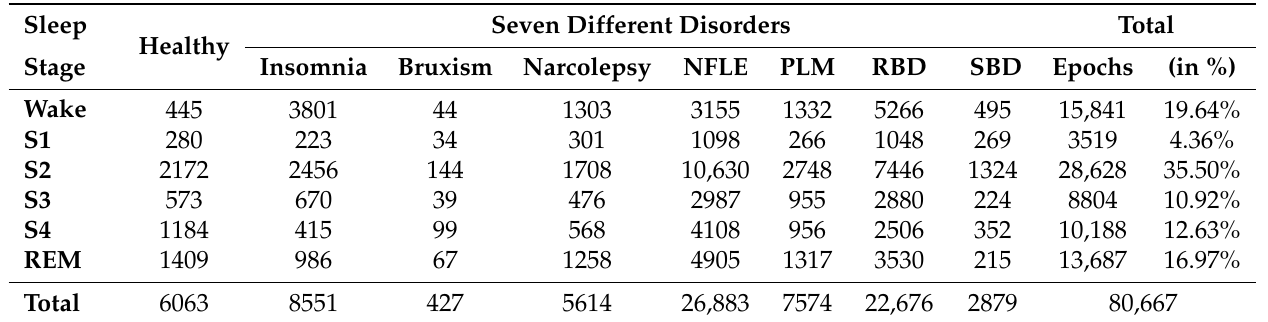
Table 3. Sleep stage-wise and subject-wise details of epoch distribution in the original unbalanced